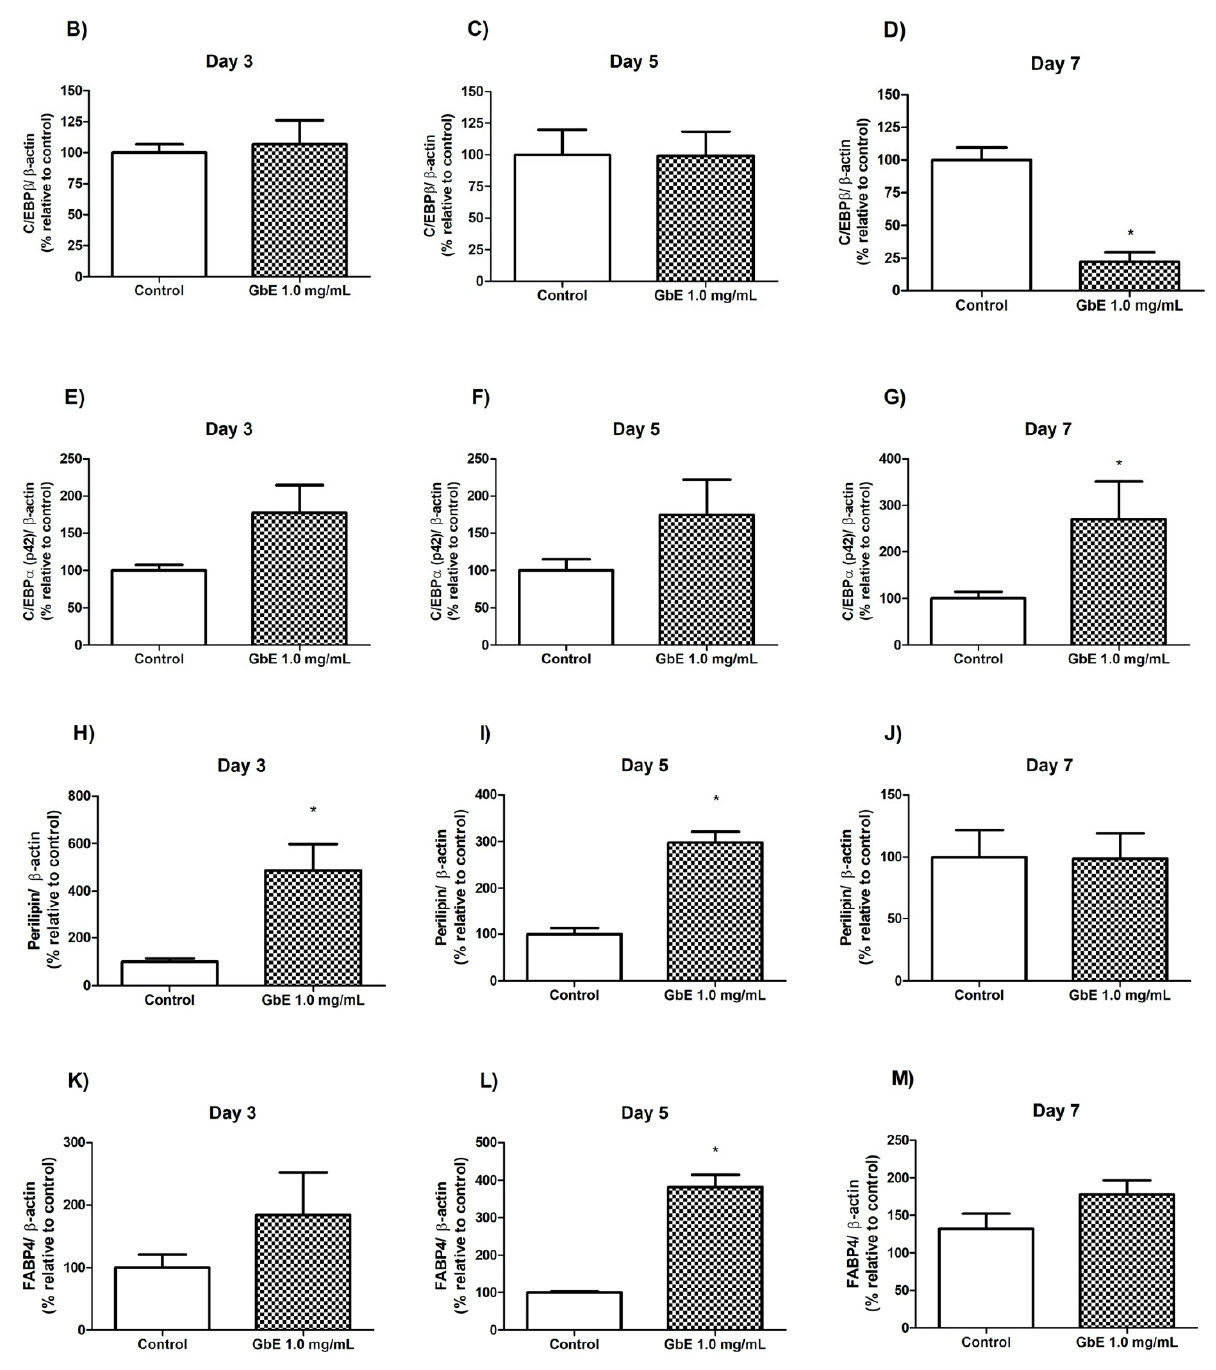
Figure 4. ( A ) GbE treatment stimulated adipocyte proteins during the differentiation process in 3T3-L1 cells analyzed by Western blotting. C/EBP- β levels in control groups and treated with GbE for: ( B ) 3 days ( n = 6), ( C ) 5 days ( n = 6) and ( D ) 7 days ( n = 5–6); C/EBP α levels in control groups and treated with GbE for: ( E ) 3 days ( n = 5), ( F ) 5 days ( n = 5), and ( G ) 7 days ( n = 4–5). Perilipin-1 levels in control groups and treated with GbE for: ( H ) 3 days ( n = 5–6), ( I ) 5 days ( n = 6), and ( J ) 7 days ( n = 6). FABP4 levels in control groups and treated with GbE for: ( K ) 3 days ( n = 4), ( L ) 5 days ( n = 3–4), and ( M ) 7 days ( n = 4). The values were normalized to the average of control group levels. Results are expressed as mean ± SEM from two independent experiments. Student’s t -test. * p ≤ 0.05 vs. control.